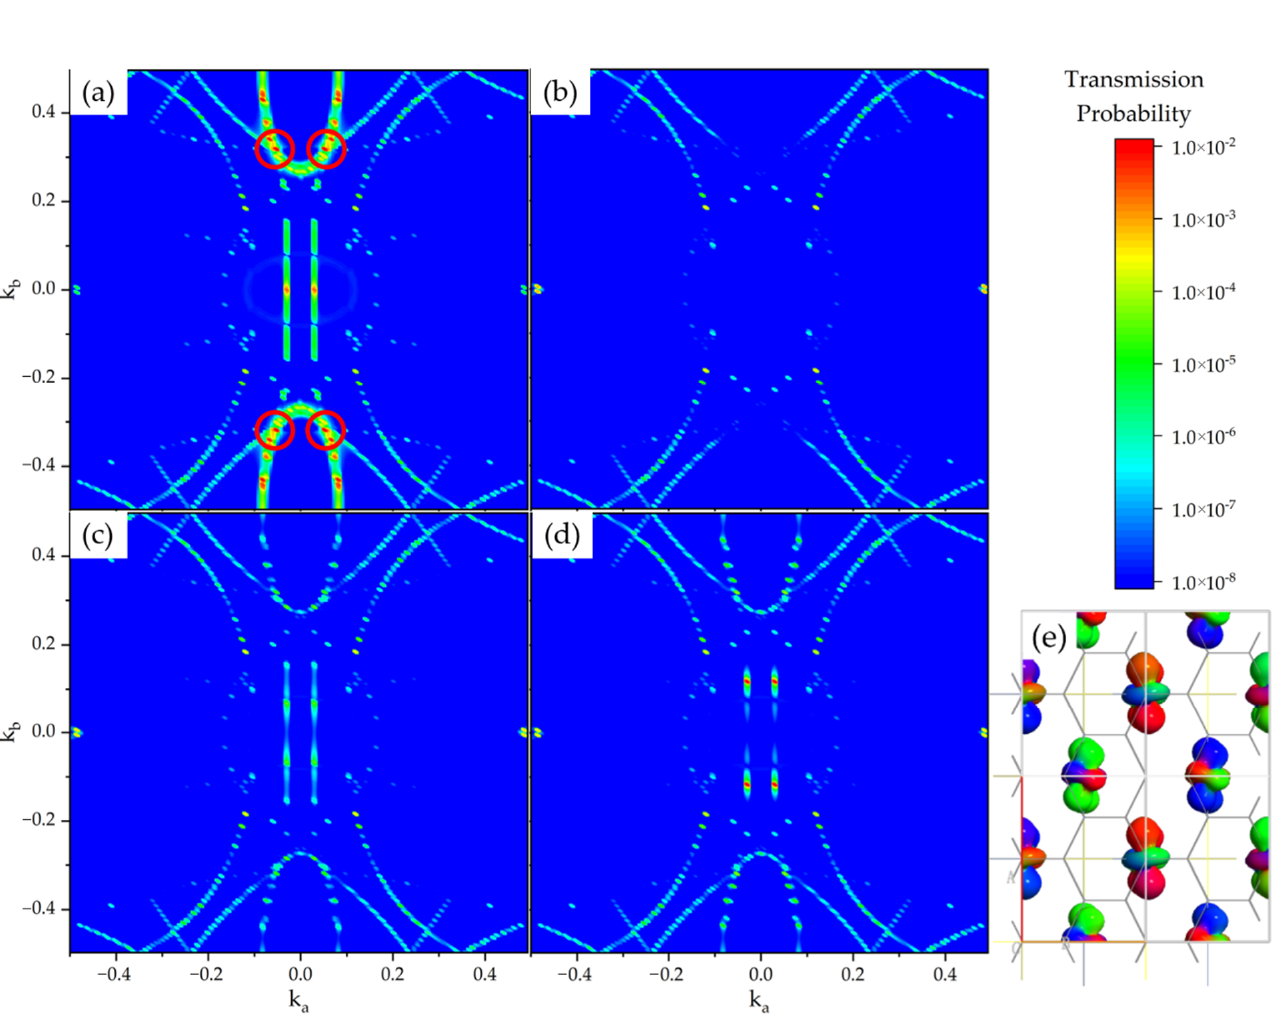
Figure 4. The transmission spectra (transmission probabilities of electrons with different transverse Bloch wave vectors) of ( a ) Majority spin states in PC; ( b ) Minority spin states in PC; ( c ) Majority spin states in APC; and ( d ) Minority spin states in APC. The colors represent different transmission probabilities with a logarithmic for presenting more information. ( e ) The transmission eigenstates of the spots with the highest probability in ( a , b ) are from a c axis perspective. The figures are the calculated results of the modeling.